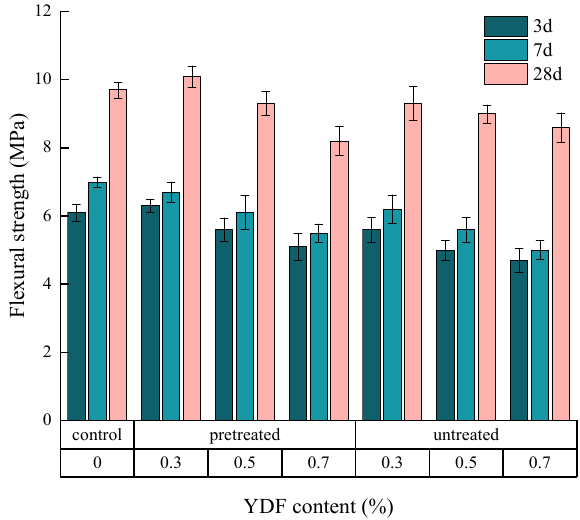
Figure 10. The relationship between the YDF content, the YDF type and the flexural strength of the cement mortar at different curing ages.